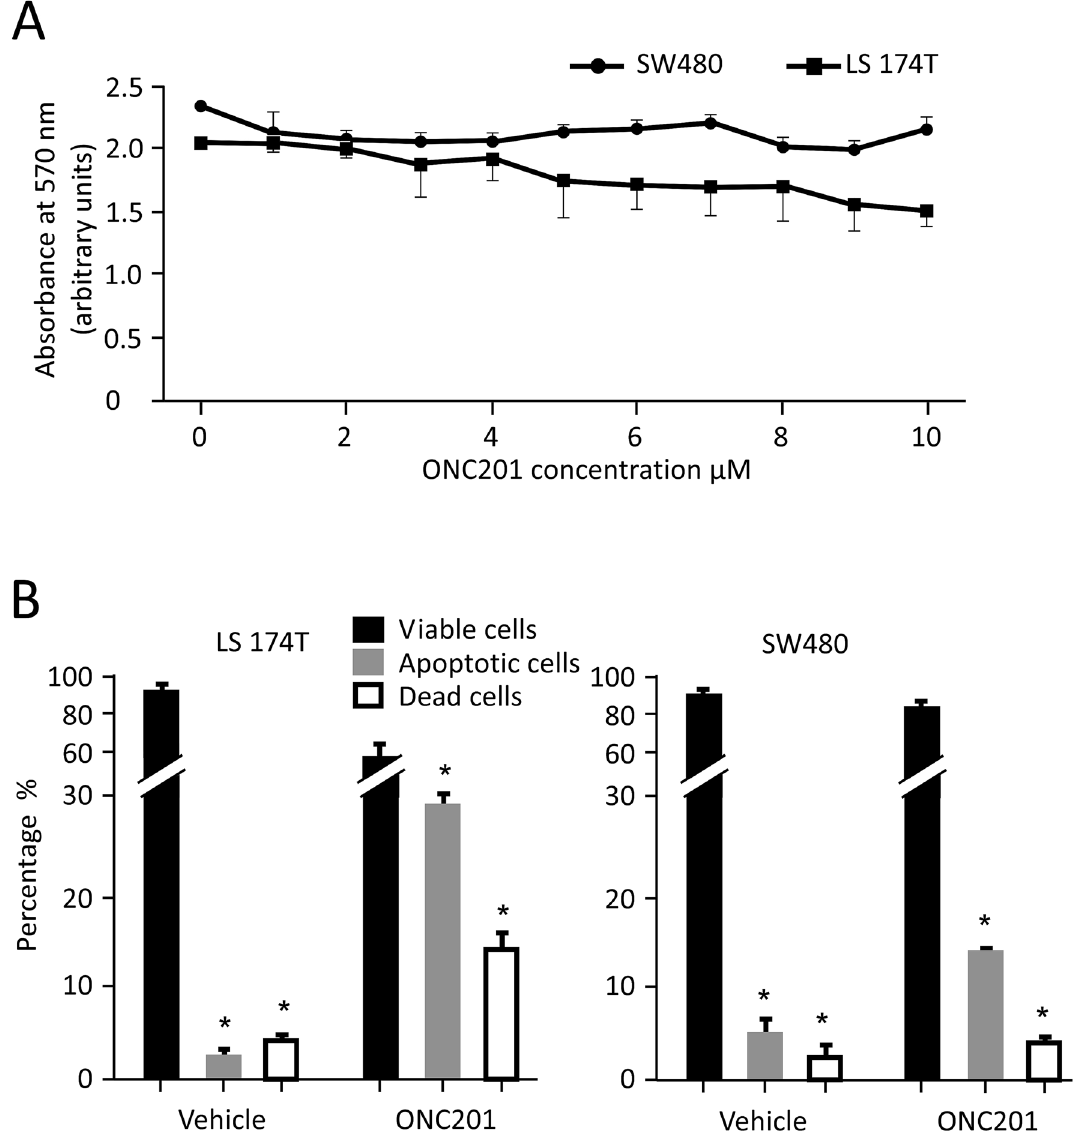
Figure 1. Response of Dukes’ type B colorectal adenocarcinoma cell lines to ONC201 treatments. ( A ) Dose- dependent response of metastatic LS-174T and nonmetastatic SW480 cells to ONC201 treatment. Cells were plated in a 96-well plates, cell viability was assayed by MTT and detected using spectrophotometer. ( B ) Flow cytometric analysis of LS-174T and SW480 cells treated with or without 10 μM ONC201 for 48 h. Apoptotic cells were detected using annexin V kit, values are expressed as mean ± SD. Significant values were set as * P < 0.01 (n = 3 each in